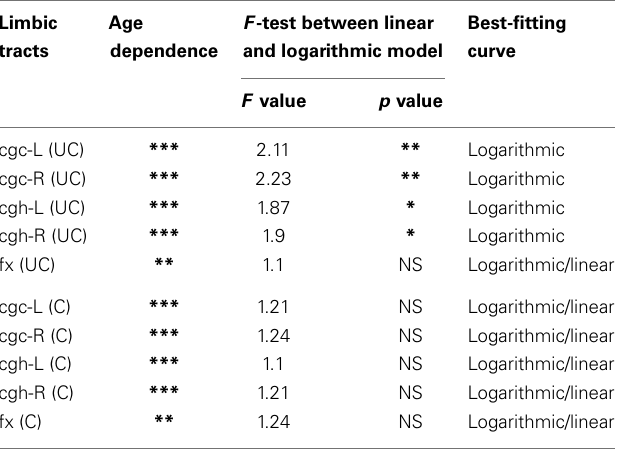
Table 3 | Relationship between axial diffusivity (AD) of limbic tracts and age .